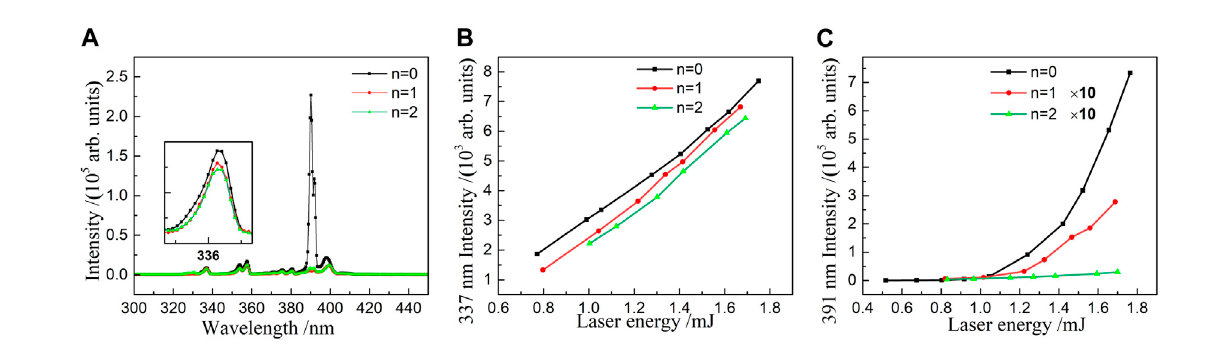
FIGURE 3 (A) Variation of the fl uorescence spectra induced by fi lamentation of OV beams with different TCs in nitrogen gas when the pulse energy is 1.25 mJ and the gas pressure is 1,200 Pa. The enlarged fl uorescence spectra at 337 nm are shown in the inset for visual convenience. (B) 337-nm emission intensity versus the pulse energy for different TCs when the nitrogen gas pressure is 1,200 Pa (C) 391-nm emission intensity versus the pulse energy for different TCs when the nitrogen gas pressure is 1,200 Pa, and the intensities for n = 1 and n = 2 are multiplied by a factor of